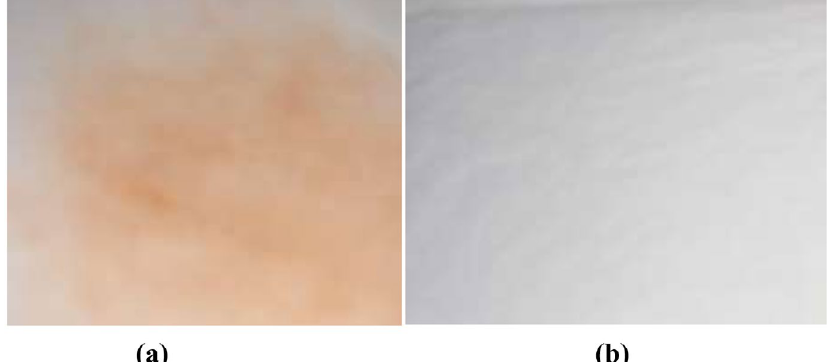
Fig. 7. Images of anti-redeposition effect of mannanase with tennis court clay on cotton cloth (a) without mannanase (b) with